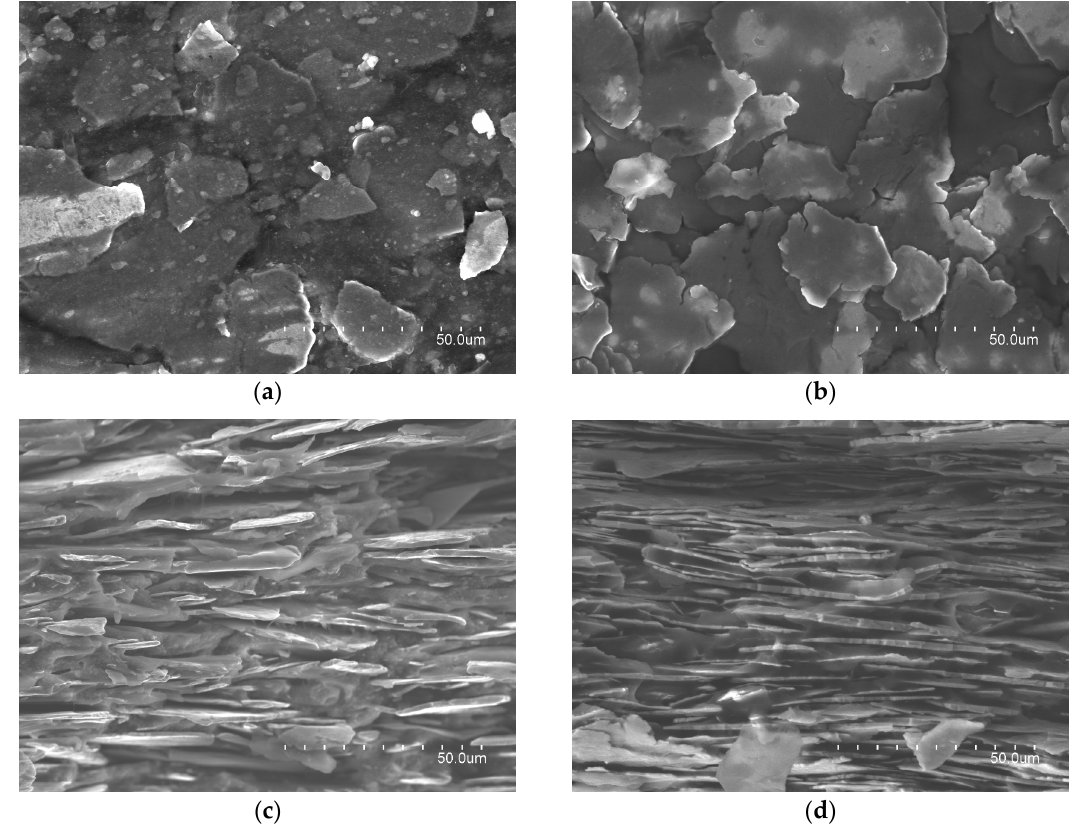
Figure 1. SEM photographs of electromagnetic absorber materials: ( a ) 304 material composition; ( b ) 3441 material composition; ( c ) cross-section of 304 material composition; and, ( d ) cross-section of 3441 material composition.